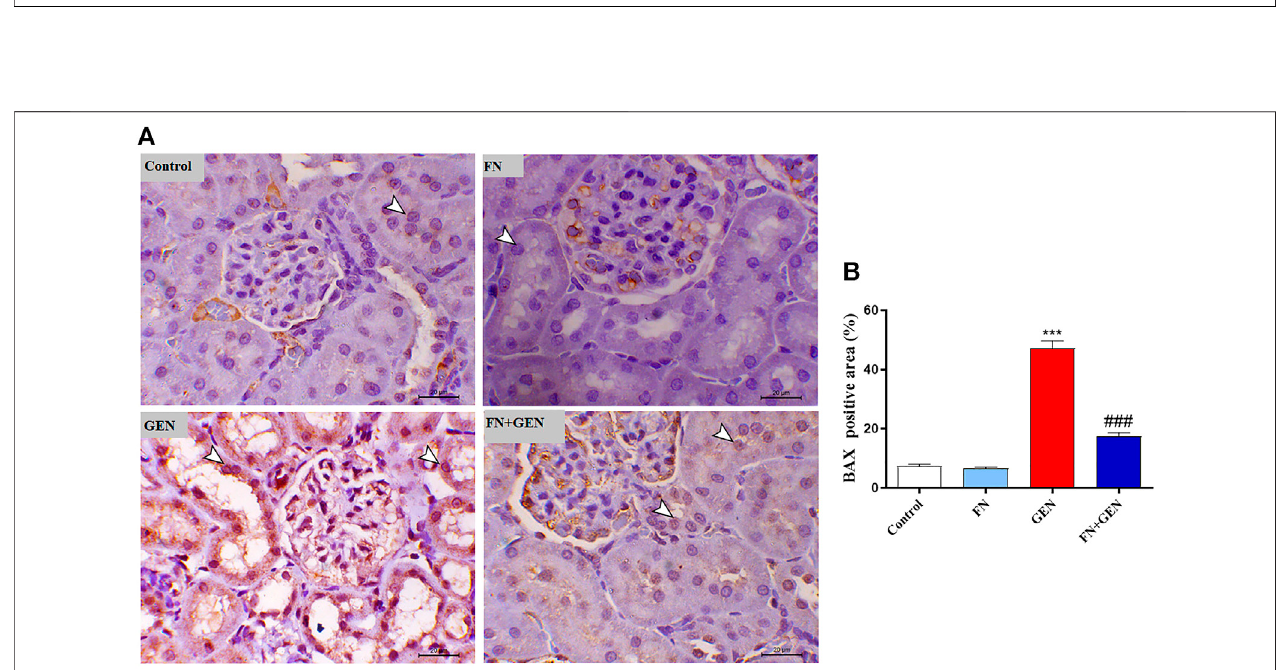
FIGURE 7 | FN downregulates BAX in GEN-intoxicated kidney. (A) Photomicrographs of renal sections from control rats and FN-treated rats demonstrating mild expressionofBAXwithintherenaltubularepithelium(arrowheads),GEN-treatedratsanimaldemonstratinganoticeableincreaseinBAXexpressionwithinthecytoplasm and nucleus of the renal tubular epithelium (arrowheads), and GEN-administered rats pre-treated with FN demonstrating marked decrease in the expression of BAX withintherenaltubularepithelium(arrowheads)(IHC,X200,scalebar=20 µm). (B) ImageanalysisofBAXimmunostaininginthekidneyofratsshowingasigni fi cant increase in GEN-administrated rats and a signi fi cant decrease in FN-treated animals. Results are mean ± SEM ( n = 6). ppp indicates p < 0.001 versus control group, and ### indicates p < 0.001 versus GEN group. FN: formononetin; GEN: gentamicin; and BAX: Bcl-2-associated X protein.